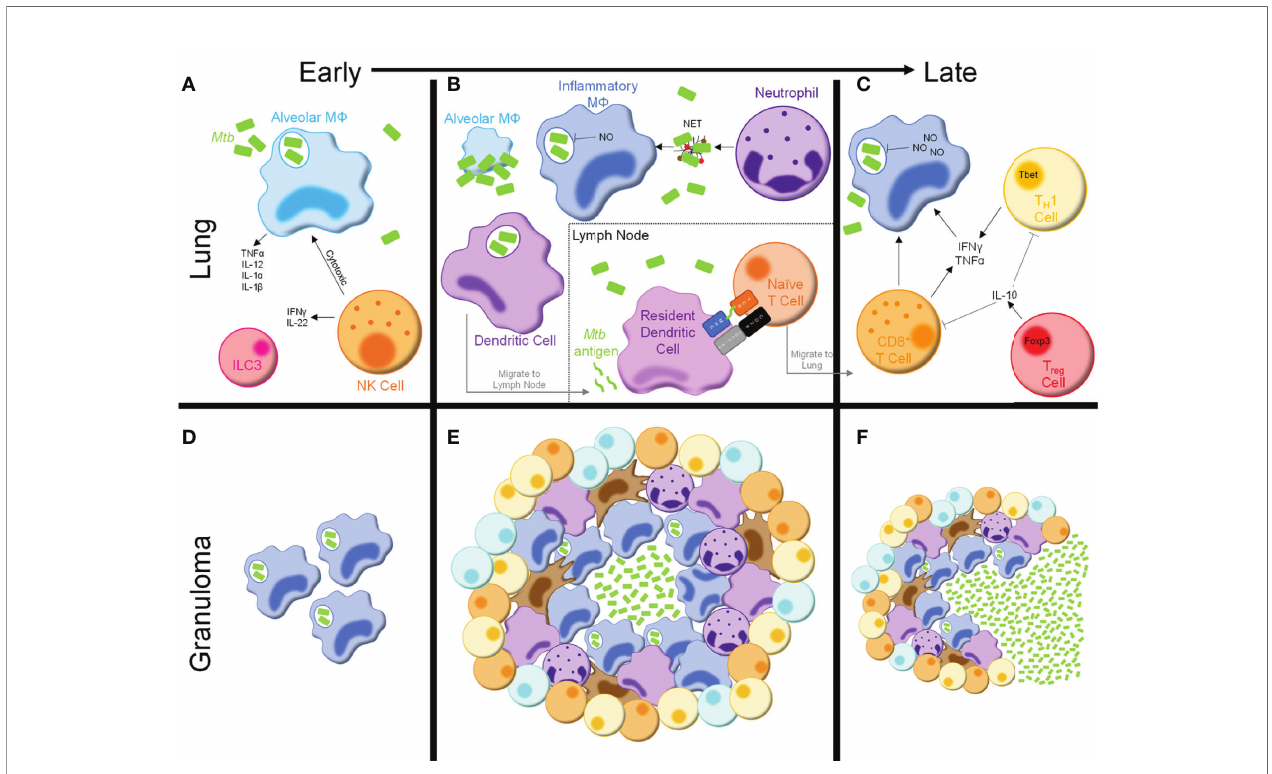
FIGURE 1 | Immune response to Mycobacterium tuberculosis . (A) Following inhalation, Mtb bacilli are phagocytosed by alveolar macrophages in the lung, resulting in cytokine and chemokine production. NK cells are innate lymphocytes that are cytotoxic to infected alveolar macrophages and produce in fl ammatory cytokines. Group 3 innate lymphoid cells (ILC3s) are also present in the lung early following Mtb infection. (B) As infection progresses, alveolar macrophages are overrun with Mtb bacilli and undergo cell death. In fl ammatory macrophages, neutrophils, and dendritic cells are recruited from the bloodstream. In fl ammatory macrophages produce mycobactericidal nitric oxide (NO) and phagocytose Mtb -containing neutrophil extracellular traps (NETs), secreted by neutrophils. Dendritic cells phagocytose Mtb bacilli and migrate to the draining lymph node, where they secrete Mtb antigens to be presented by resident dendritic cells, initiating naïve T cell activation. (C) After migrating to the lymph node, activated T cells secrete in fl ammatory cytokines, including interferon (IFN) g and tumor necrosis factor (TNF) a , which further stimulate macrophage anti-mycobacterial activity. Activated CD8 + T cells are also cytotoxic to infected macrophages. T reg cells produce cytokines, such as IL-10, to inhibit the activity of other lymphocytes in the lung. (D – F) Concurrently, granulomas begin to develop in the lung. (D) Early granulomas consist of aggregations of infected phagocytes. (E) Mature granulomas consist of a core of Mtb bacilli, infected macrophages, and multinucleated giant cells surrounded by more macrophages, neutrophils, dendritic cells, and fi broblasts. The outside of the granuloma consists of T and B cells, forming a lymphocytic cuff. (F) As infection progresses and potentially following some degree of immunosuppression the granulomas begin to break down, leading to dissemination of Mtb bacilli and reactivation of TB